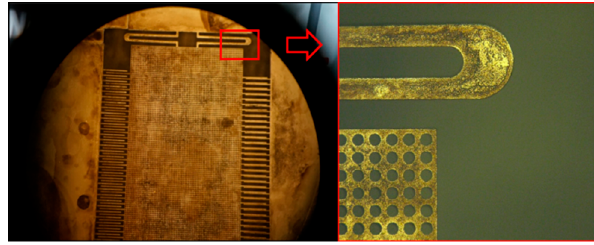
Figure 13. The final result of the combination processing of dry etching and wet etching.